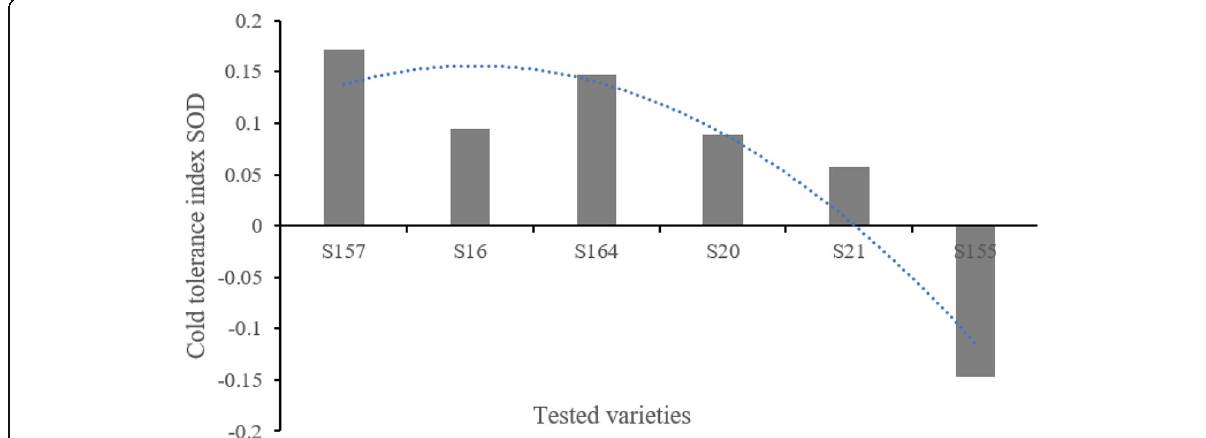
Fig. 2 SOD changes in six selected weedy rice varieties. The changes in superoxide dismutase (SOD) content are shown along with the cold- tolerance capacity of the different varieties. The positive value represents a relative increase compared with the control group (untreated group), and the negative value represents a relative decline compared to the control group (untreated group), S157 (WR157), S16 (WR16), S164 (WR164), S20 (WR20), S21 (WR21) and S155 (WR155) represented 6 diffferent